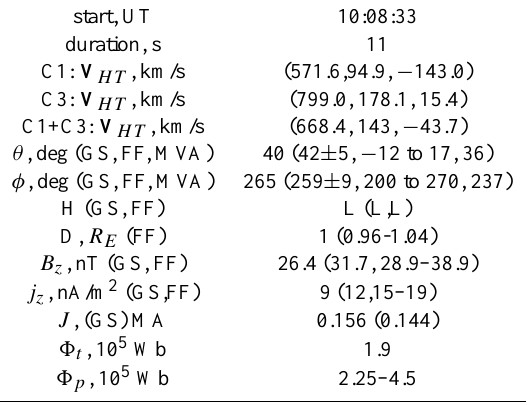
Table 1. Results of the multi-spacecraft Grad-Shafranov recon- struction (GS2) for the CLUSTER flux rope on 22 August 2001 10:08:33–10:08:45UT. Minimum variance analysis (MVA) and sin- gle s/c GS was carried out for C3, and force-free fitting (FF) re-